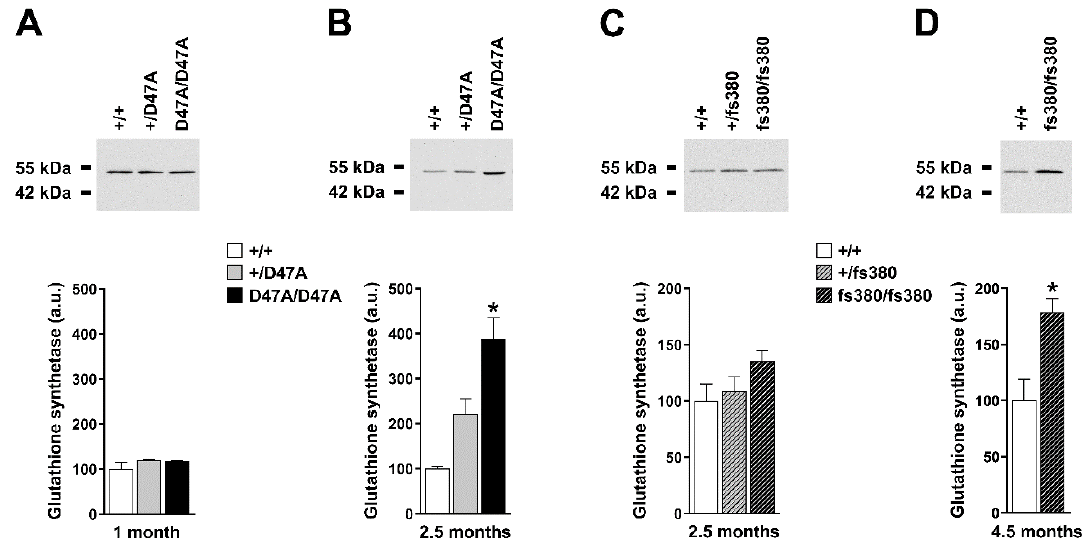
Figure 2. Levels of glutathione synthetase in Cx50D47A and Cx46fs380 lenses. ( A , B ) Top panels. Immunoblots of glutathione synthetase in whole lens homogenates from 1- (A) and 2.5- (B) month-old mice that were wild type for Cx50 (+/+) or heterozygous (+/D47A) or homozygous (D47A/D47A) for Cx50D47A. The migration positions of the molecular mass markers are indicated on the left. Bottom panels. Graphs show the densitometric quantification of the glutathione synthetase immunoreactive band obtained in 3 independent experiments. Data are presented as the mean (bar) + standard error of the mean. ( C , D ) Top panels. Immunoblots of glutathione synthetase in whole lens homogenates from 2.5- (C) and 4.5- (D) month-old mice that were wild type for Cx46 (+/+) or heterozygous (+/fs380) or homozygous (fs380/fs380) for Cx46fs380. The migration positions of the molecular mass markers are indicated on the left. Bottom panels. Graphs show the densitometric quantification of the glutathione synthetase immunoreactive band obtained in three independent experiments. Data are presented as the mean (bar) + standard error of the mean. Asterisk denote a significant difference compared with wild-type lenses ( p < 0.05). Levels of glutathione synthetase in 2.5-month-old heterozygous Cx50D47A lenses were not significantly different than wild-type ( p = 0.07).